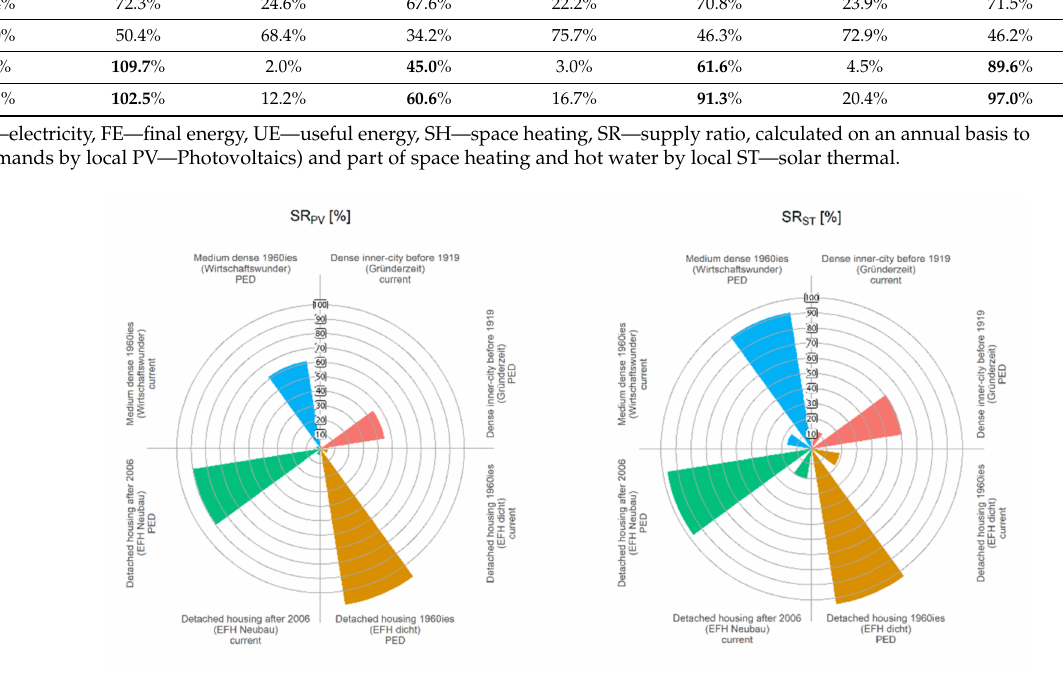
Figure 7. Supply ratio of PV—Photovoltaics and ST—solar thermal for the four analysed typologies in Vienna (source: